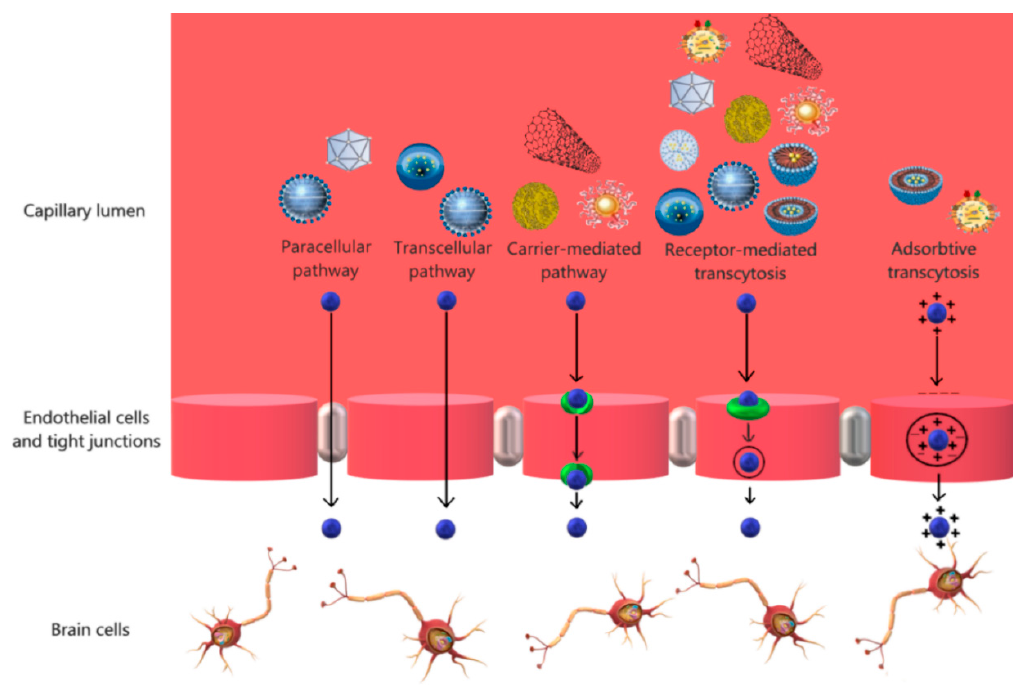
Figure 2. The main pathways of crossing the BBB for each type of the described nanocarriers